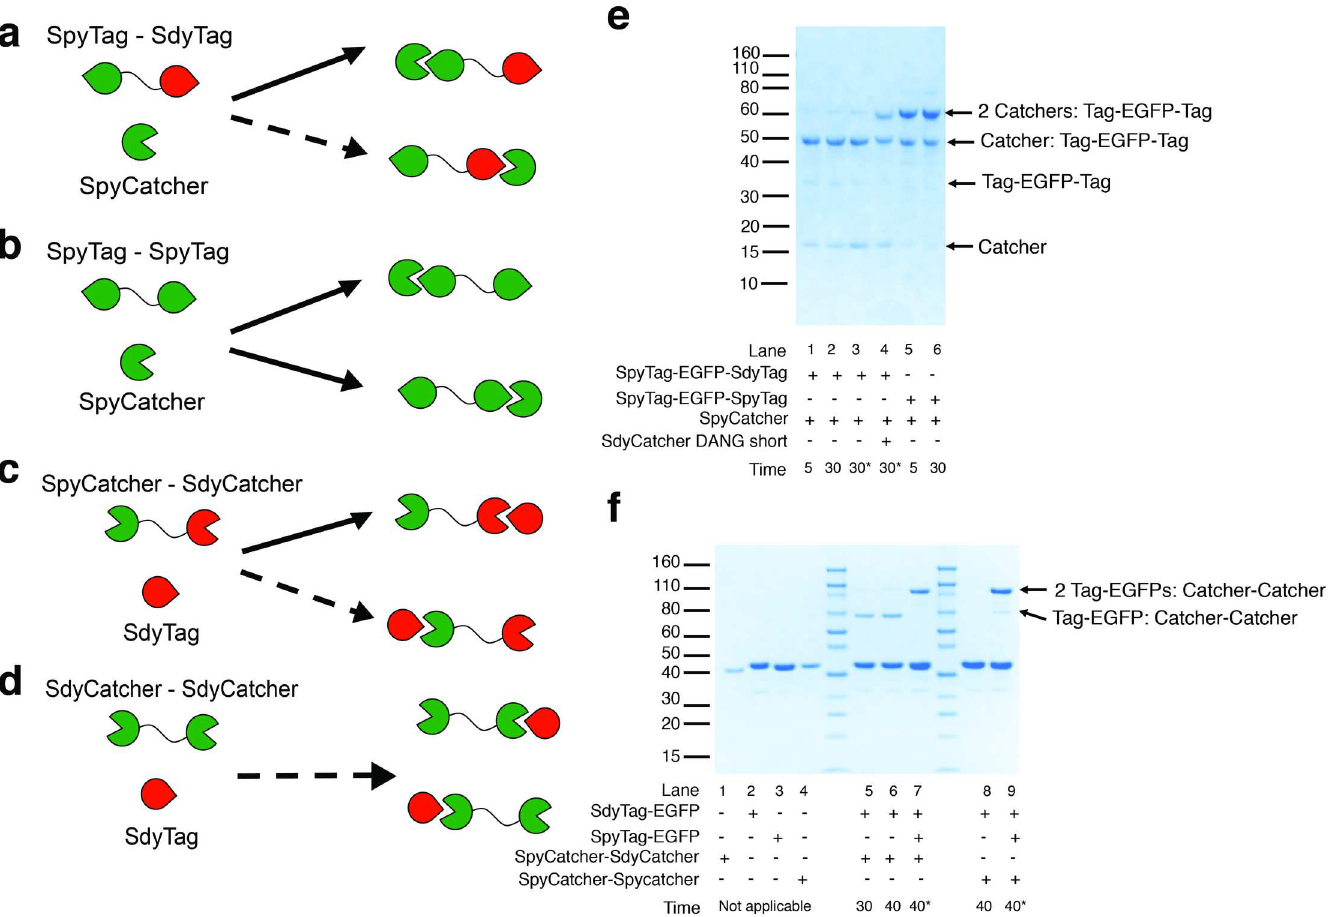
Fig 4. Kinetic control for directed protein assembly. Predicted preferences, based on observed reaction rates of SpyCatcher with (a) SpyTag- EGFP-SdyTag construct (preference for SpyTag versus SdyTag) compared to (b) SpyTag-EGFP-SpyTag construct (no preference for either SpyTag). Predicted preferences for SdyTag-EGFP are shown in (c) SpyCatcher-SdyCatcher DANG short (preference for SdyCatcher) and (d) SpyCatcher-SpyCatcher (minimal reactivity expected). Bold arrows represent fast reaction comparedto the dotted arrows which represent slow or minimal reactions. (e) Reactions of the dual-Tags constructs. Reaction of SpyTag-EGFP-SdyTag with SpyCatcher at 5 minutes (lane 1) and 30 minutes (lane 2). At 5 minutes, aliquots were removed and incubatedwith additionalSpyCatcher (lane 3) or additionalSdyCatcher DANG short (lane 4) for a further 25 minutes. Reaction of SpyTag- EGFP-SpyTag with SpyCatcher at 5 minutes (lane 5) and 30 minutes (lane 6). (f) Reactions of the dual-Catcher constructs. Lane 1–4 are standalone purifiedSpyCatcher- SdyCatcher DANG short , SdyTag-EGFP, SpyTag-EGFP, SpyCatcher-SpyCatcher respectively. Incubation of SpyCatcher- SdyCatcher DANG short with excess SdyTag-EGFP for 30 and 40 minutes (lanes 5 and 6). An aliquot of the reaction after 30 minutes was removed and incubated with excess SpyTag-EGFP for further 10 minutes (lane 7). Reaction of SpyCatcher-SpyCatcher with excess SdyTag-EGFP for 40 minutes (lane 8). Excess SpyTag-EGFP was incubatedwith an aliquot of the latter reaction, after 30 minutes, for a further 10 minutes (lane 9). Astericks indicate the reactions which additionalsubstrates were incubated in the reactions. Novex Sharp pre-stained ladder was used in both